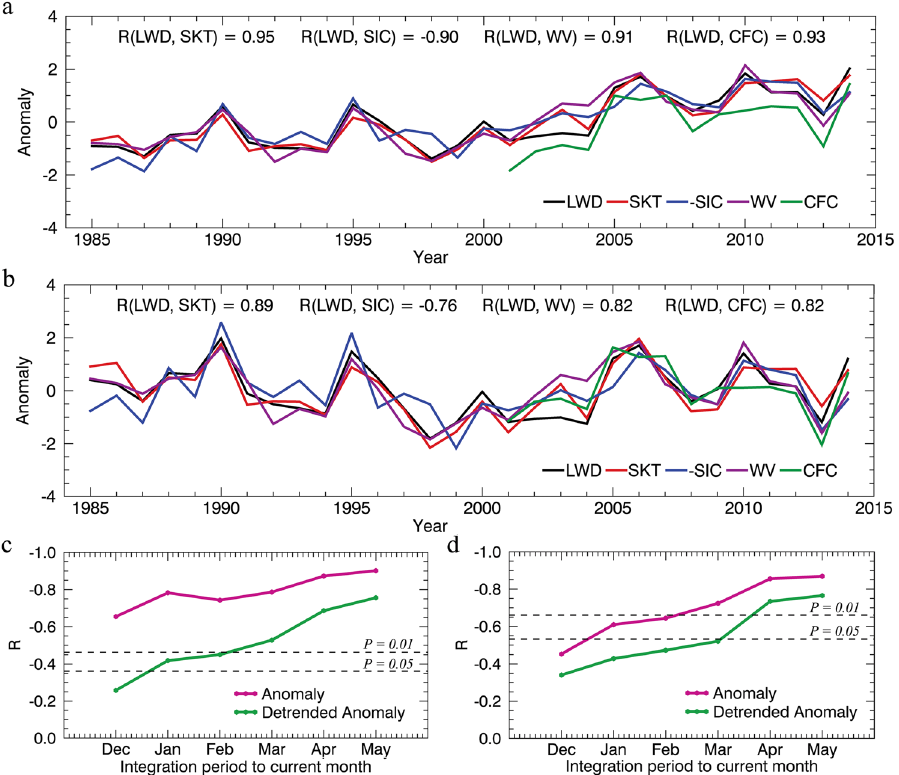
Figure 1. Anomalies in five spatially averaged variables for the Arctic Ocean, and the correlation coefficients between integrated surface LWD and inverted onset SIC (-SIC anomaly). Anomalies in surface LWD, SKT, CFC, and WV are averaged from December to May, and the inverted initial SIC from May 16 to June 5, ( a ) before and ( b ) after de-trending. All time series were normalized based on their corresponding standard deviations. Panels ( c ) and ( d ) show the correlation coefficients between integrated surface LWD from December to a given month and the SIC at onset of melting from May 16 to June 5 during the periods ( c ) 1985–2014 and ( d ) 2001–2014. This figure has been created with IDL8.3 (Exelis Visual Information Solutions, Boulder,